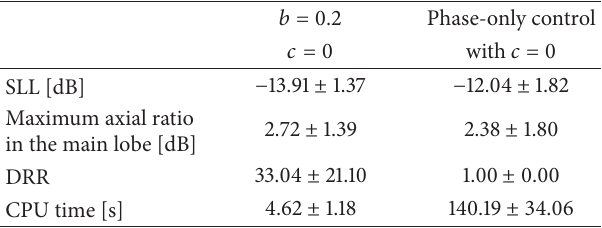
Table 4: Results obtained for the two-dimensional scanning of the region [64 ∘ , 116 ∘ ] × [64 ∘ , 116 ∘